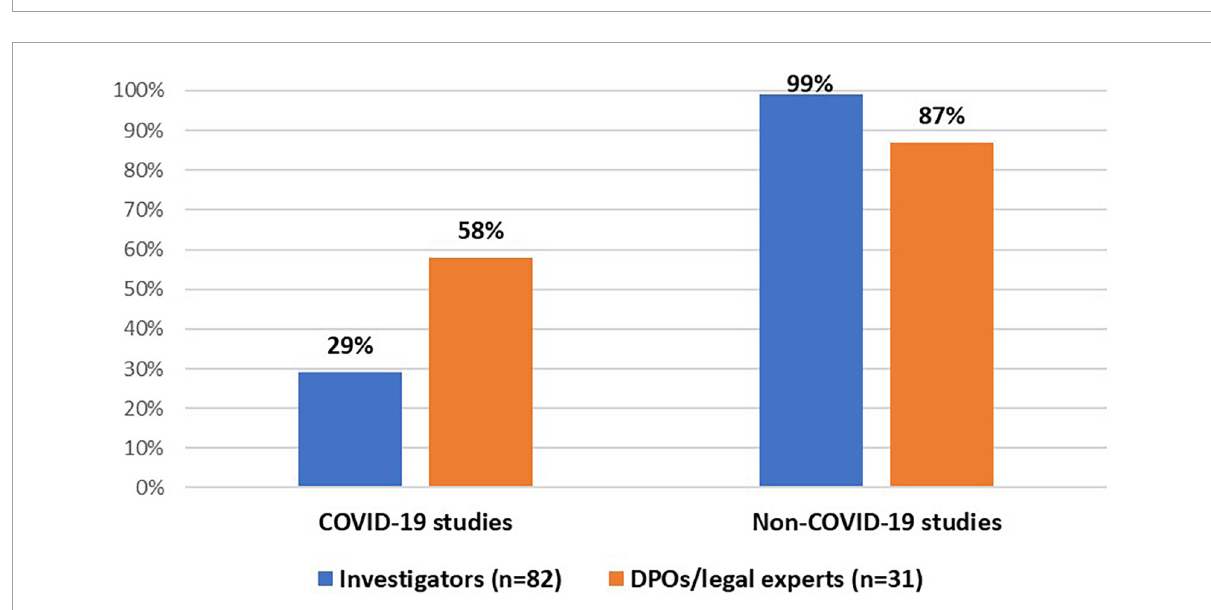
FIGURE1 Stakeholders’ experiences with clinical studies.